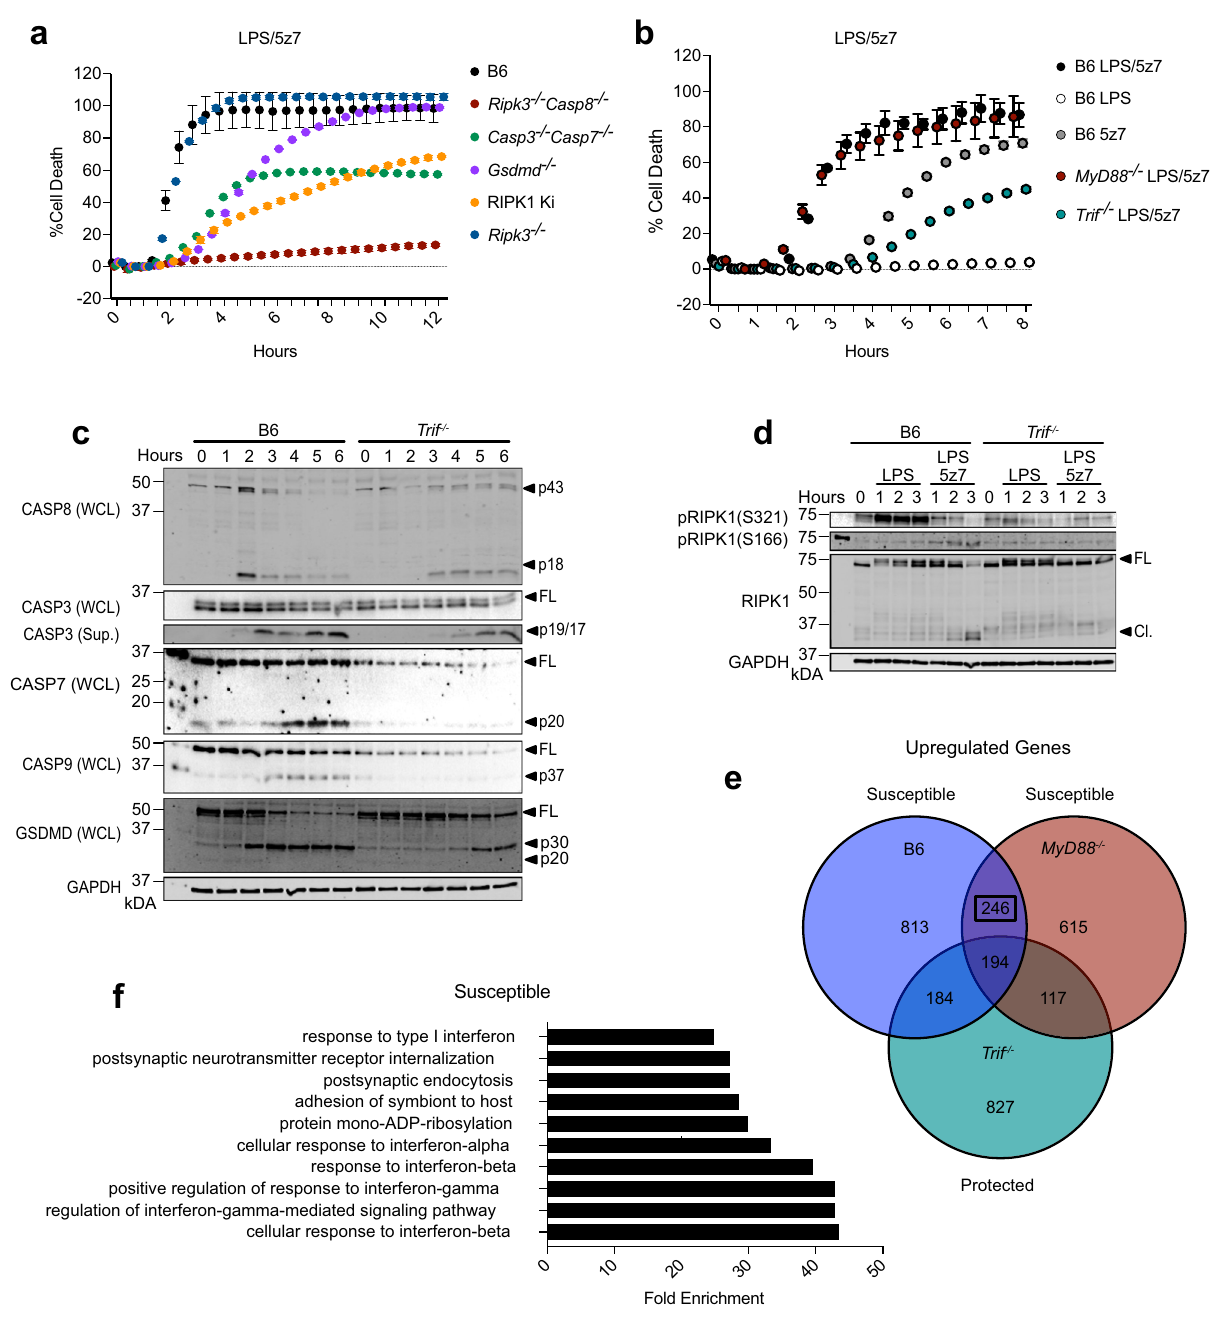
Fig. 1 TRIF is required for CASP8-mediated cell death. a , b Cell death over time as measured by propidium iodide incorporation in indicated BMDMs stimulated with LPS, 5z7, or LPS/5z7. c Full-length and cleaved products of indicated caspases and GSDMD from whole-cell lysates (WCL) or precipitated from the supernatant (Sup.) of B6 or Trif − / − BMDMs stimulated with LPS/5z7 for 1 – 6 h. d Levels of total, pRIPK1 (S166), and pRIPK1 (S321) in B6 or Trif − / − BMDMs stimulated with LPS or LPS/5z7 for 1 – 3 h. e Comparison of genes upregulated (>1.7-fold) after 1 h of LPS/5z7 treatment compared to unstimulated in B6, Myd88 − / − , or Trif − / − . f Top upregulated pathways identi fi ed in B6 and Myd88 − / − but not Trif − / − BMDMs after stimulation with LPS/5z7. Data from cell death assays and western blots are representative of 3 or more biologically independent experiments, cell death data are presented as the mean ± SD of triplicate wells, n = 10,000 cells examined in three individual wells. Source data for all experiments are provided as a Source data fi le. See also Supplementary Fig.